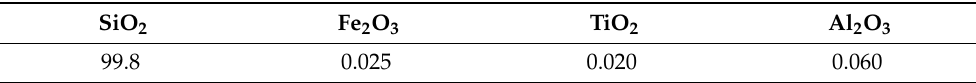
Table 1. Silica analysis (wt%).